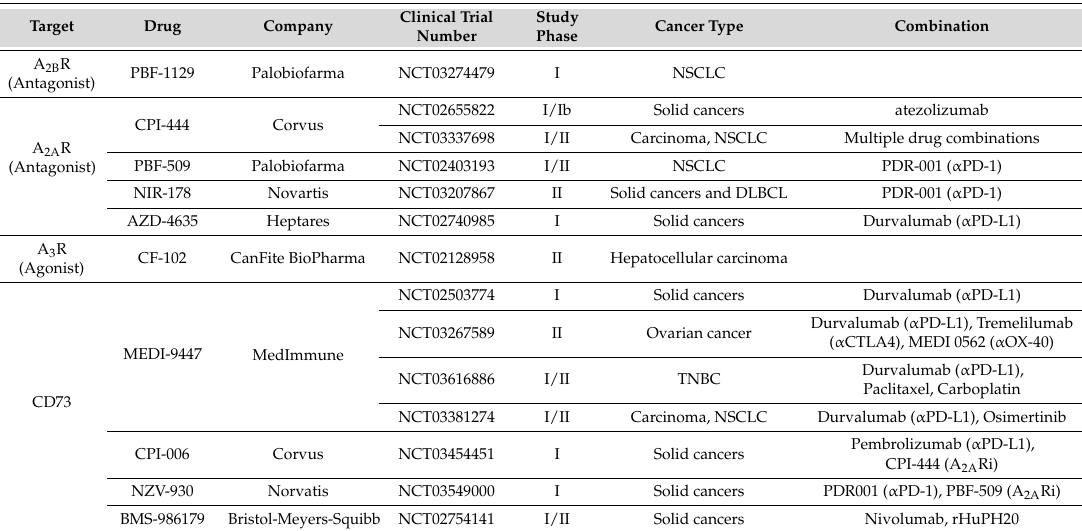
Table 1. Ongoing or upcoming clinical trials targeting the adenosine